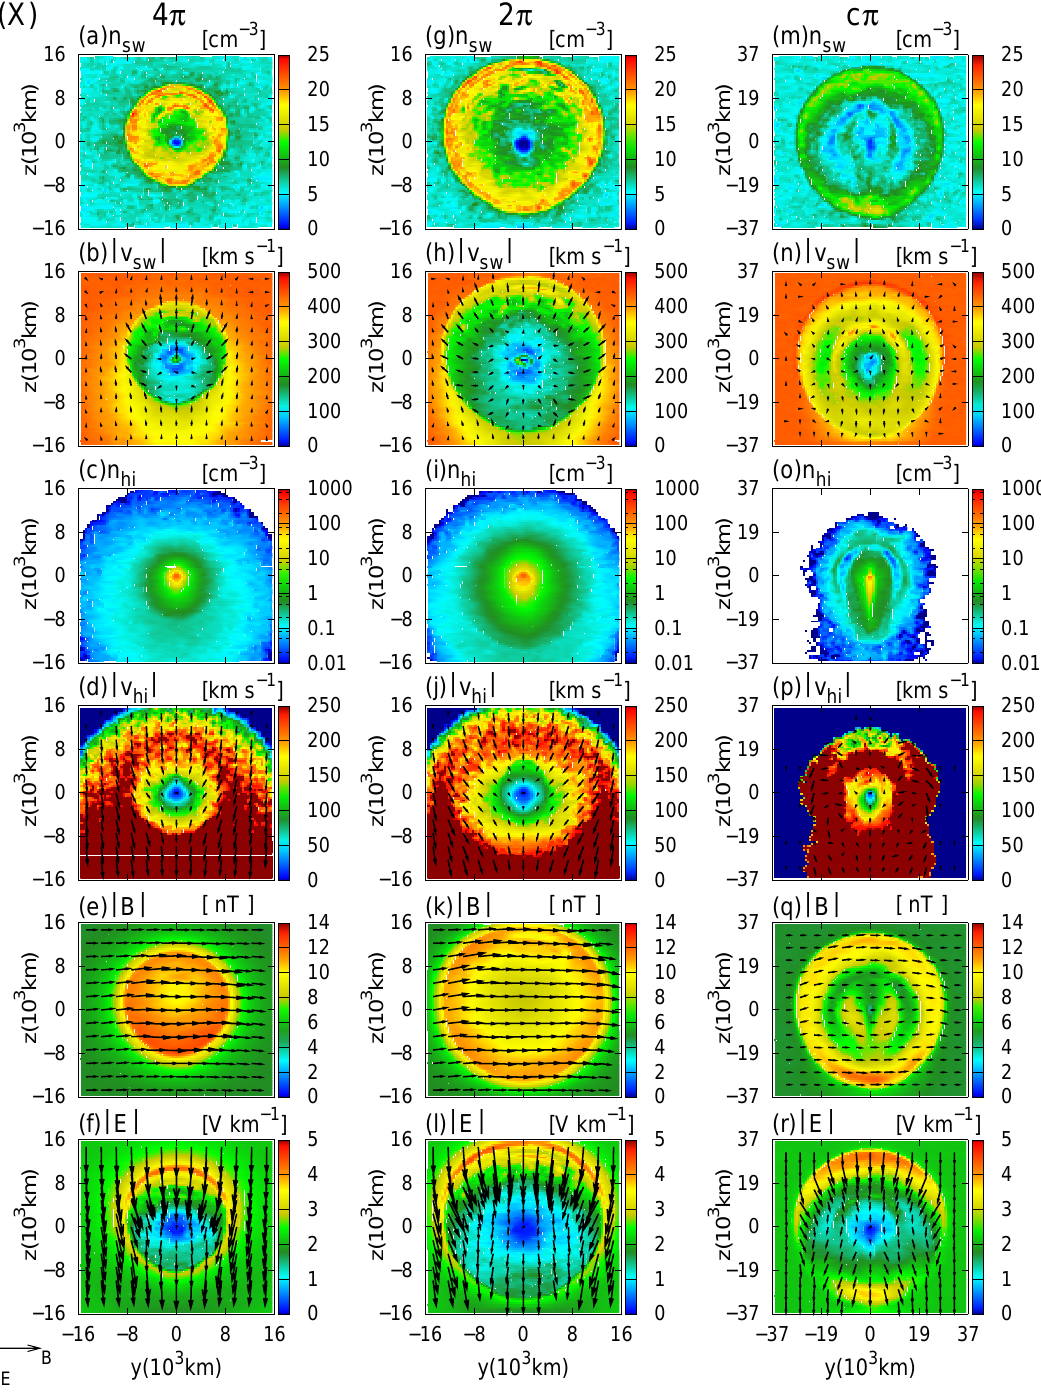
Fig. 8. Cut through the terminator plane of the simulation box at 1.30AU. From left to right the results of the spherically symmetric, the day side restricted and the cone shaped model are shown. The solar wind density ( a, g, m ) and bulk velocity ( b, h, n ), the cometary ion density ( c, i, o ) and bulk velocity ( d, j, p ), the magnetic ( e, k, q ) and the electric field ( f, l, r ) are the presented quantities. The interplanetary magnetic field points in +x while the convective electric field points in − z direction. The predominant particle transport in − z direction is clearly visible in the solar wind and cometary ion bulk velocities. Spatial confinment causes clear differences in the cometary ion density between the c π case and the other two models. In (o) we can see the spatial constraints on the activity of the nucleus due to the cone shape model. Since the MBR has a larger distance to the origin of the coordinate system, the situation seems to adjust to the undisturbed background flow, as shown in (q). Notice the larger spatial scale in case of the c π